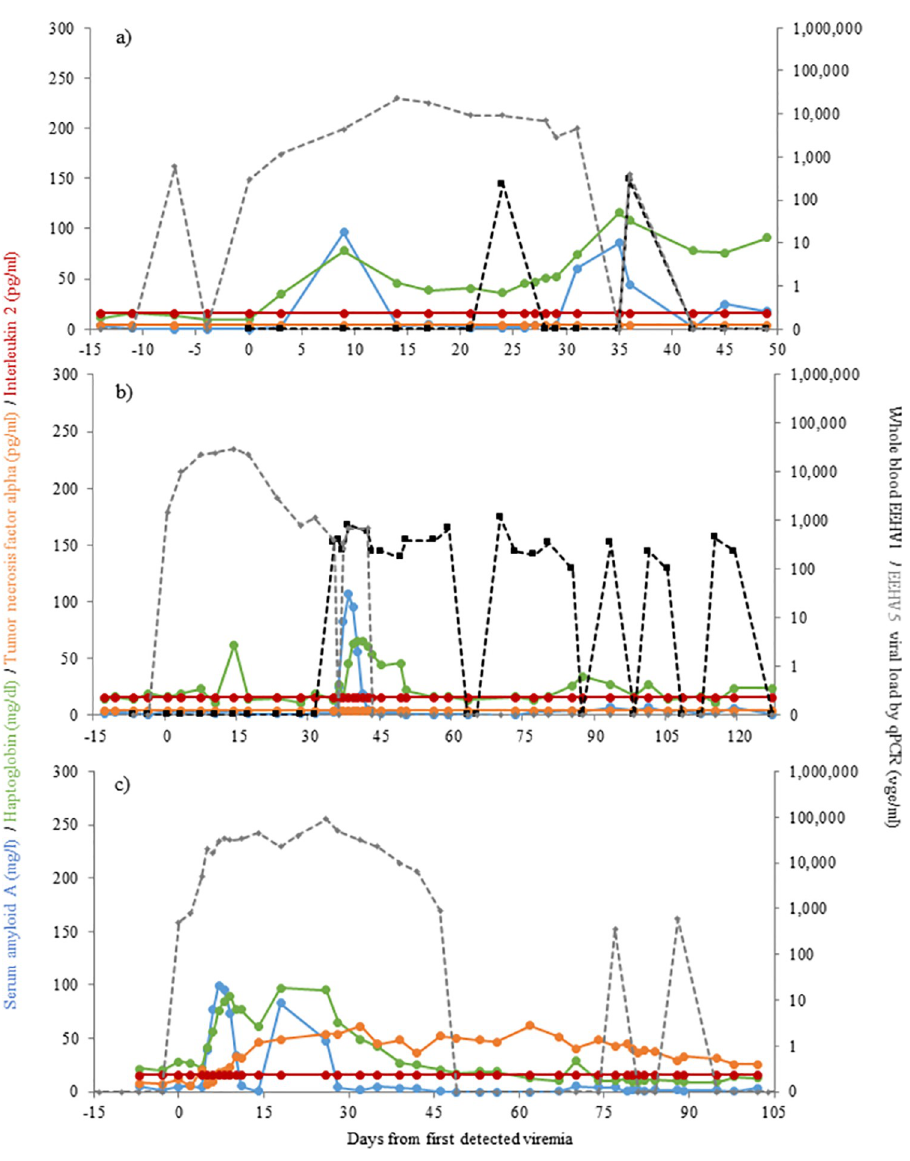
Fig 5. Biomarker concentrations during EEHV5 viremia in three female Asian elephants aged 4 y 10 m (a), 7 y 2 m (b) and 11 y 1 m (c).